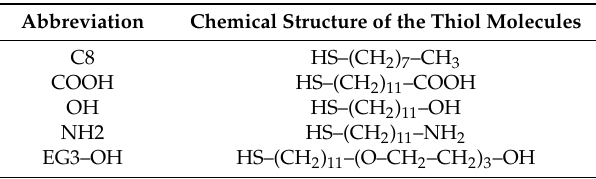
Table 1. Thiols used in this work and their chemical